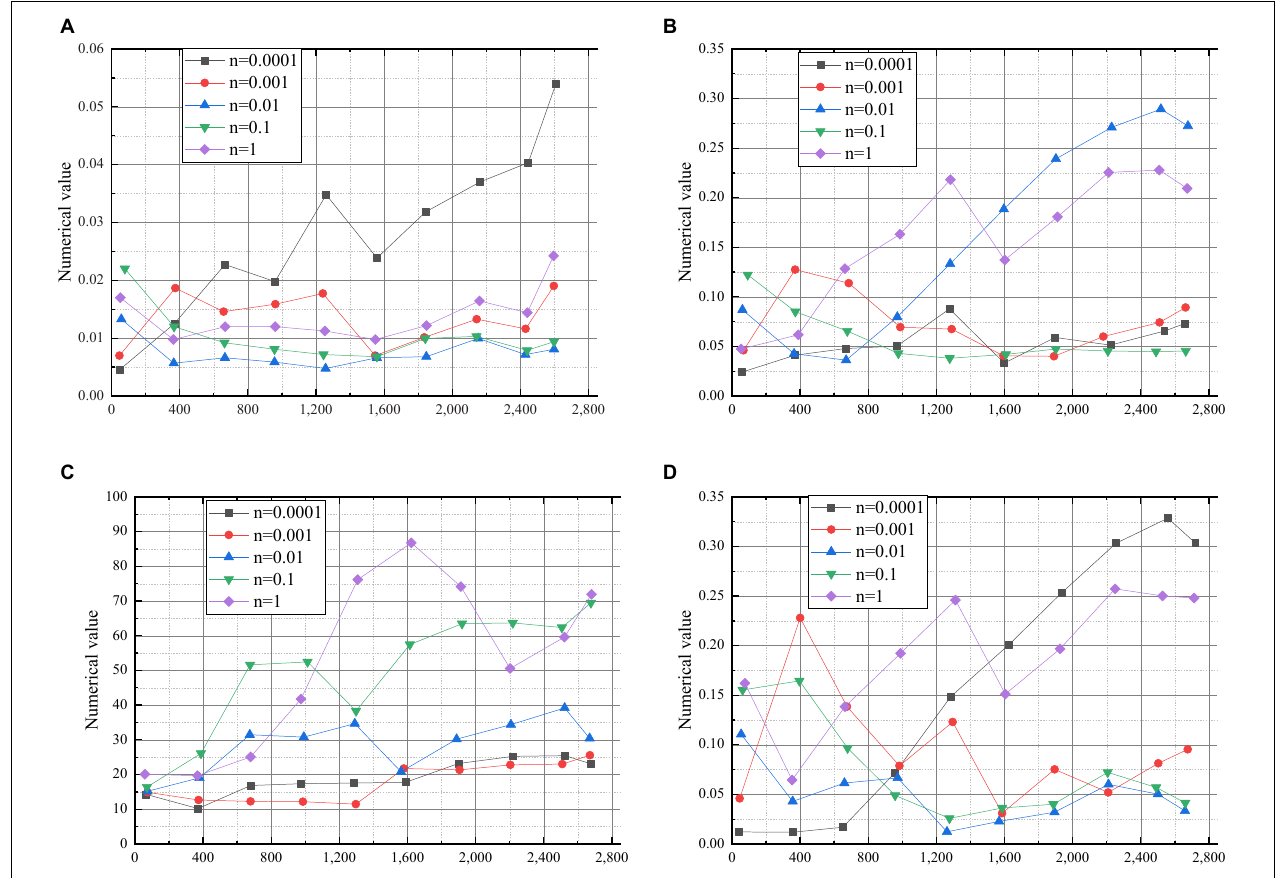
FIGURE 3 | Model data of learning rates ( A: Recall rate; B: Predict the next question; C: Test coverage; D: Quality of test questions. n = Learning